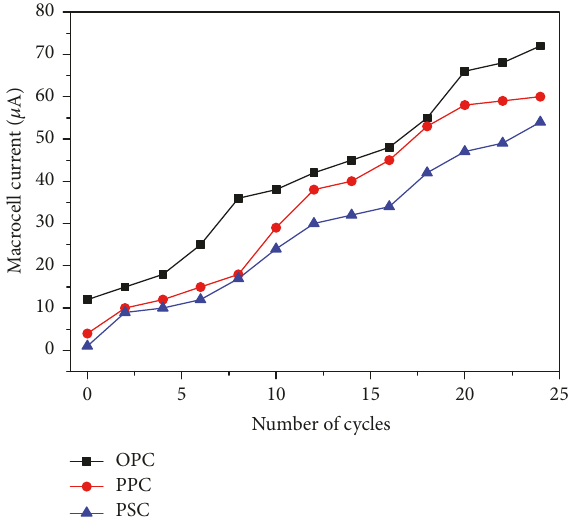
Figure 14: Total integrated current versus number of cycles of exposure for rebar in OPC, PPC, and PSC M30 grade concrete types (90-day cured specimens) under macrocell condition.